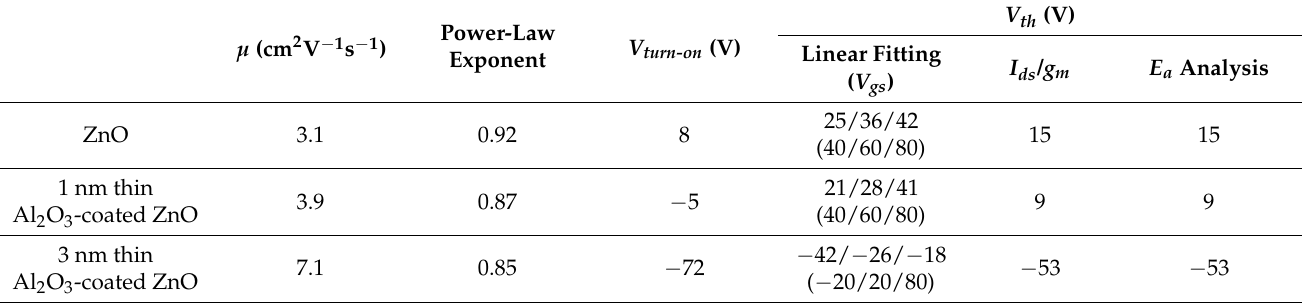
Figure 4. ( a ) The transfer curves of the Al 2 O 3 -coated ZnO TFTs. ( b ) The SIMS depth profiling of the Al 2 O 3 -coated ZnO film. ( c ) Conductivity and carrier concentrations of the ZnO films with the top Al 2 O 3 layer. ( d ) The modified I ds /gm plot for the A l2 O 3 -coated ZnO TFTs. ( e ) Temperature dependence of the transfer curves of the Al 2 O 3 -coated ZnO TFTs. ( f ) Extracted activation energies as a function of gate voltage for the Al 2 O 3 -coated ZnO TFTs. Table 1. Summary of the device parameters for the ZnO and Al 2 O 3 -coated ZnO